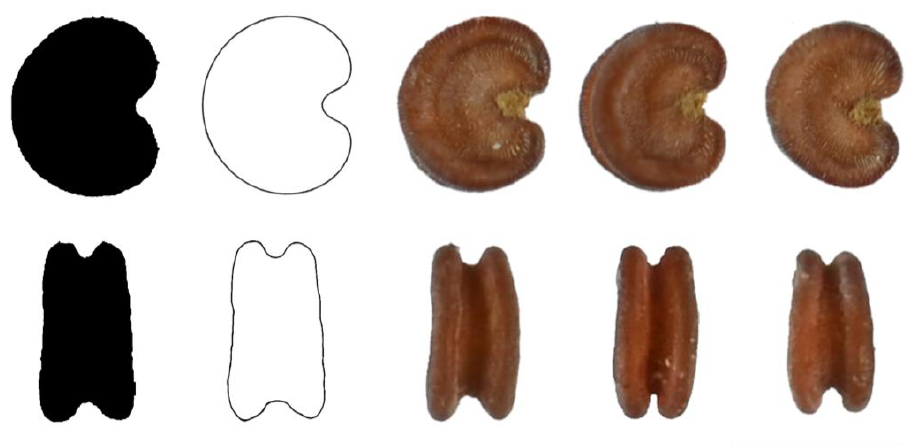
Figure 17. Silene damascena : average silhouettes (left), the models giving best scores with 20 seeds (LM5 and DM13), and three representative images for the lateral (above) and dorsal (below) seed views. Bar represents 1 mm.